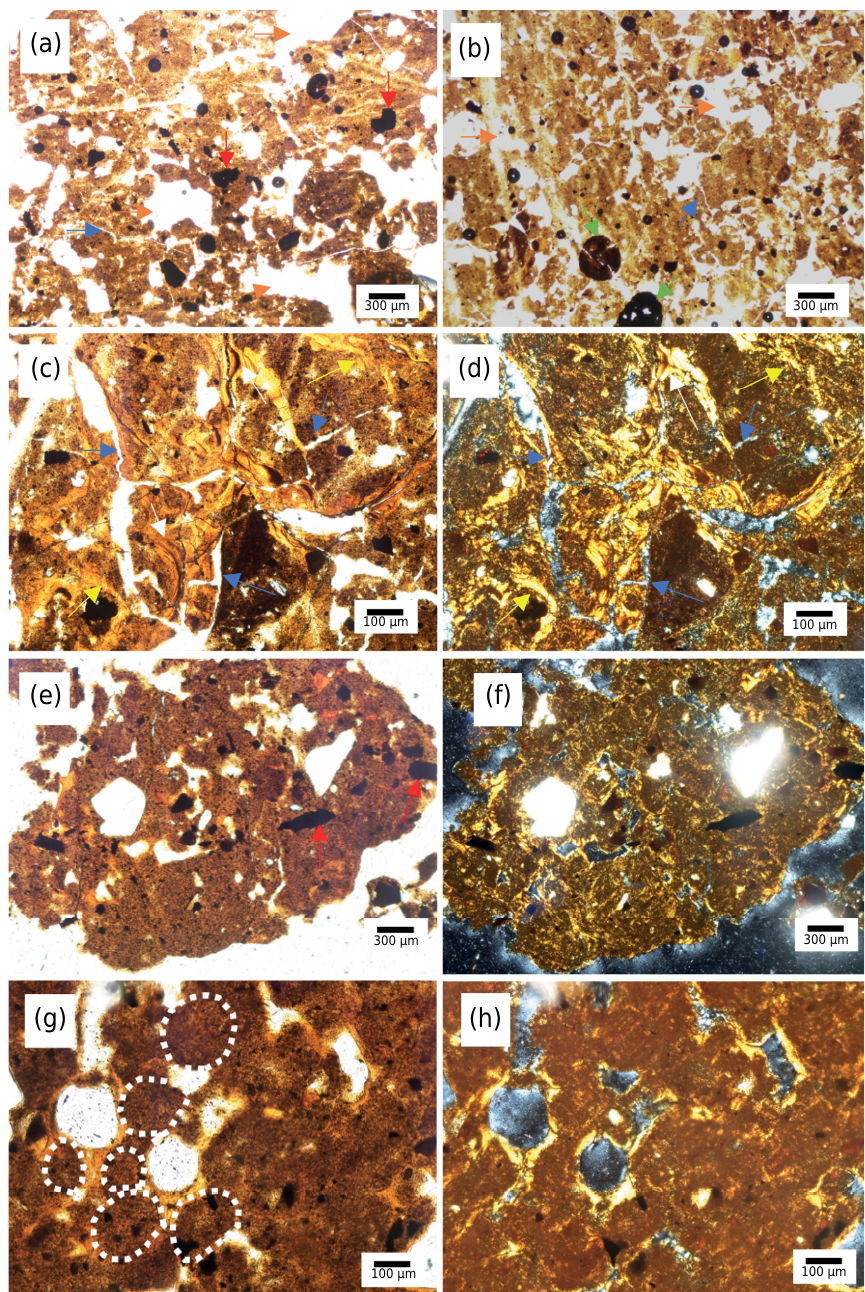
Figure 6. Representative photomicrographs of Bw horizons, highlighting: a and b – block microstructure with planar voids and granular microstructures with compound packing voids; c and d – fragmented textural pedofeatures indicating degradation of them; e and f – sub-rounded block composed by coalesced granules, with granostriated b-fabric in crossed polarized light; g and h – detail of coalesced granules. Photomicrographs in parallel polarized light: a, b, c, e, and g. Photomicrographs in crossed polarized light: d, f, and h. Symbology: blue arrows – planar voids; orange arrows – compound packing voids; purple arrows – vughs; red arrows - ilmenite with alteration (leucoxene) or magnetite with alteration (hematite); yellow arrows – clay orientation with monostriated b-fabric interpreted with a product of mechanical stress by physico-hydrical constraints; white arrows – clay coatings or infillings; green arrows – Fe-Mn-typical nodules and white dashed line – granules